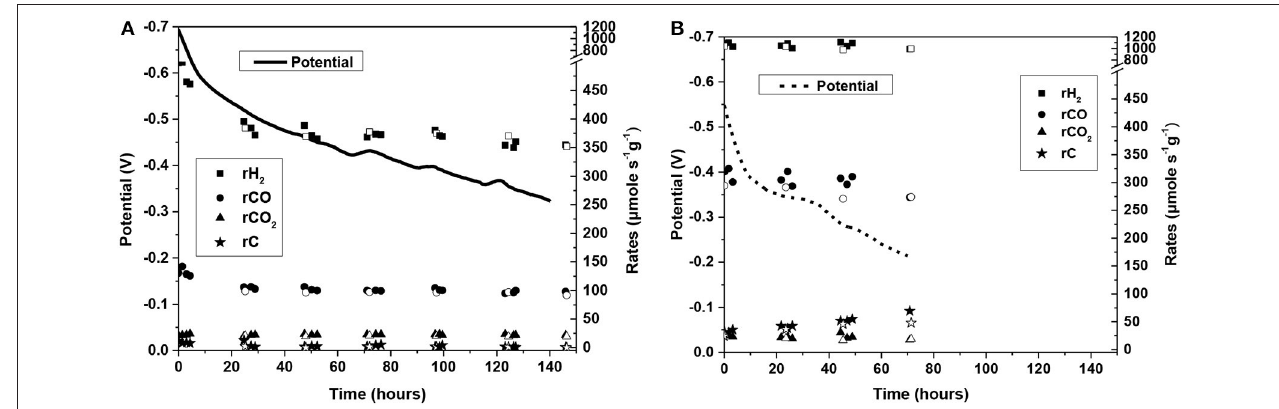
FIGURE 15 | Stability diagram of a cell with (A) 3Au-3Mo-Ni/GDC and (B) Ni/GDC as anode electrodes for the internal CH 4 steam reforming reaction. The solid and dashed lines corresponds to the evolution of the operating potential and the symbols to the production rates of: ( (cid:4) ) H 2 , ( • ) CO, ( ) CO 2, and ( ) Carbon. In particular, the closed symbols were received during the applied current, while the open symbols at O.C.P. conditions. The stability was performed at T = 800 ◦ C at applied constant current density of j = 57 mA/cm 2 . The reaction mixture comprised 22 vol.% H 2 O and 78 vol.% CH 4 with F total = 150 cc/min (S/C = 0.3 without dilution in carrier gas). Reprinted with permission from Neofytidis et al. (in press).